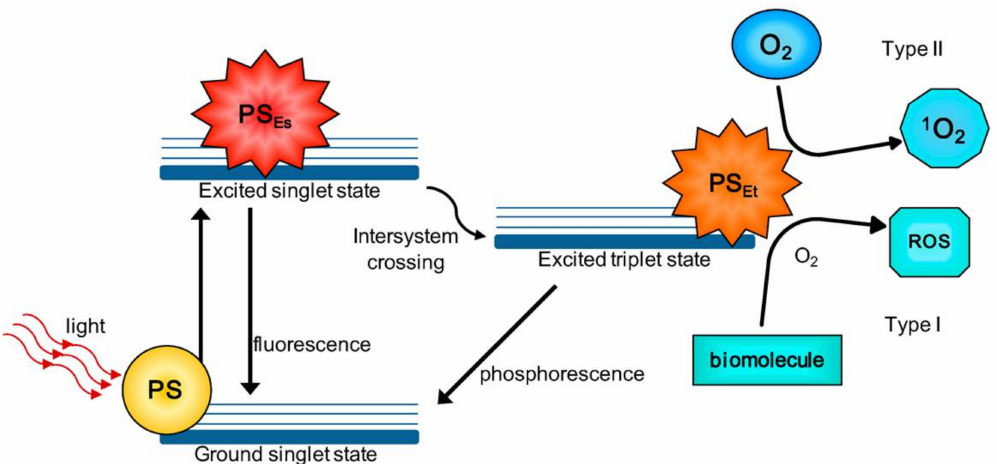
Figure 1. Mechanism of action of PDT demonstrating Type I and Type II reactions. PS Es , PS excited singlet state; PS Et , PS excited triplet state; ROS, reactive oxygen species. Reprinted with permission from ref. [26]. 2016 Calixto et